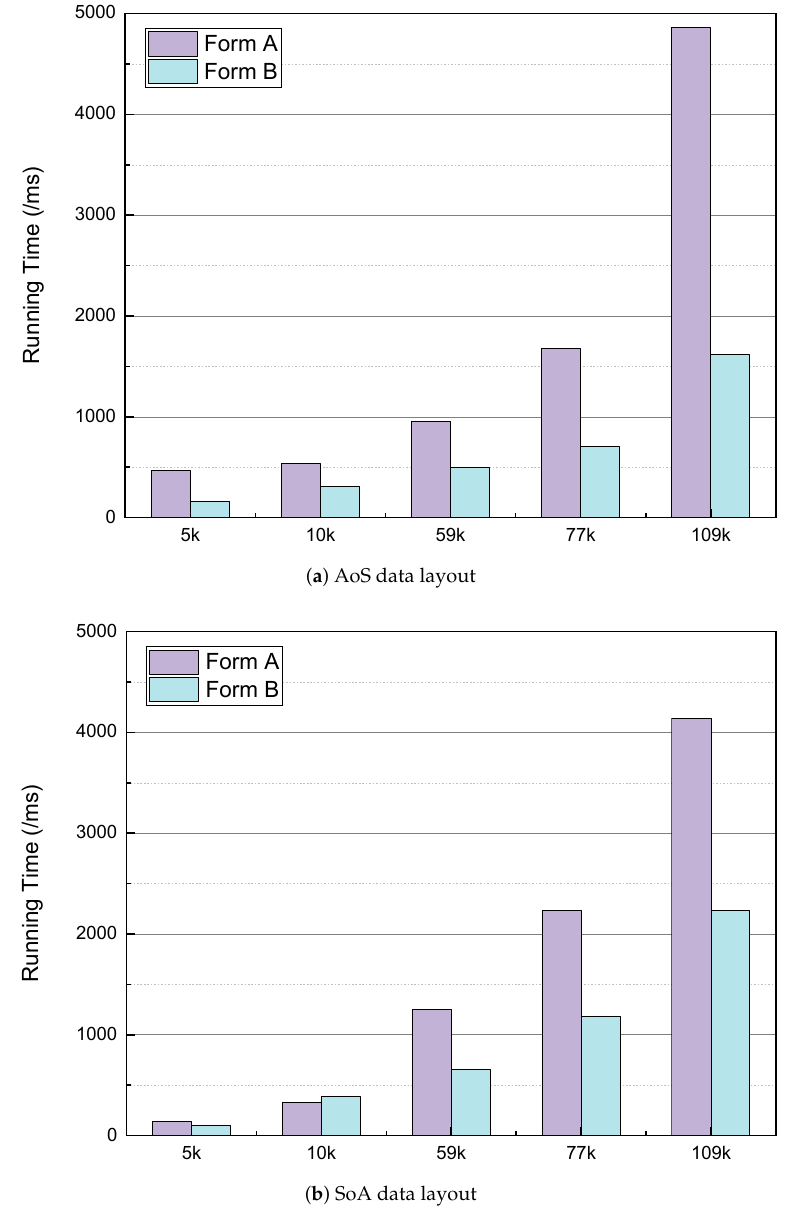
Figure 10. Running time and speedup when using different iteration